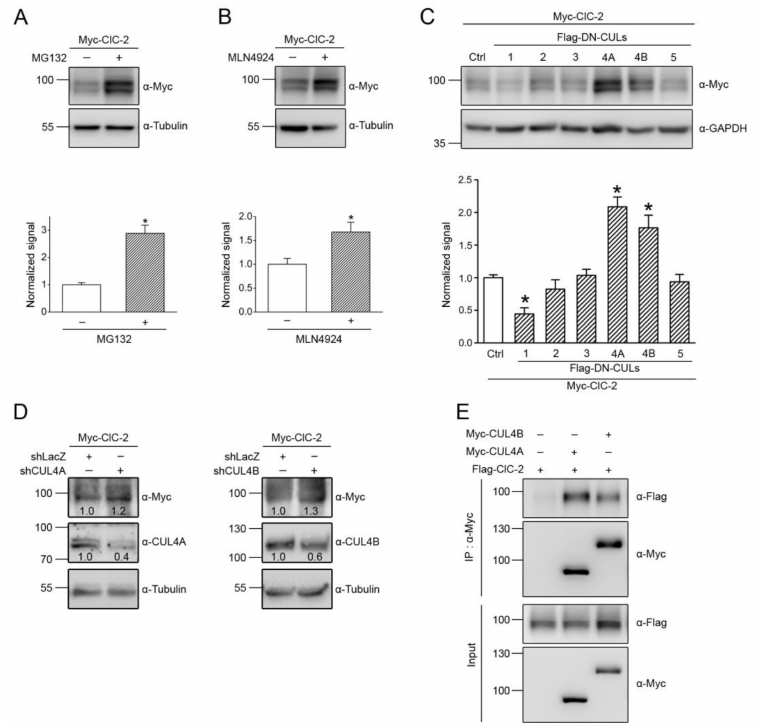
Figure 1. CUL4 mediates the protein degradation of ClC-2 channels. Myc- or Flag-tagged mouse ClC-2 channels (Myc-ClC-2, Flag-ClC-2) were overexpressed in HEK293T cells. ( A , B ) ( Upper panels ) Representative immunoblots showing the e ff ect of 24-h treatment of 10 µ M MG132 (in 0.1% DMSO) ( A ) or 10 µ M MLN4924 (in 0.1% DMSO) ( B ) on the protein expression of Myc-ClC-2. The molecular weight markers (in kilodaltons) and immunoblotting antibodies ( α -Myc and α -Tubulin) are labeled to the left and right, respectively. Tubulin was used as the loading control. ( Lower panels ) Quantification of relative ClC-2 protein levels. Protein density was standardized as the ratio of the ClC-2 signal to the cognate tubulin signal. Values from the MG-132-treated or the MLN4924-treated groups ( hatched bars ) were then normalized to those for the corresponding control ( clear bars ). Asterisks denote a significant di ff erence from the control (*, t test: p < 0.05; n = 6–12). ( C ) ( Upper panel ) Representative immunoblots illustrating the e ff ect of co-expressing Flag-tagged dominant-negative cullins (Flag-DN-CULs) on Myc-ClC-2. Co-expression with the Flag vector was used as the control experiment. GAPDH was used as the loading control. ( Lower panel ) Quantification of relative ClC-2 protein levels in the presence of various Flag-DN-CUL constructs (*, t test: p < 0.05; n = 7–16). ( D ) Representative immunoblots showing the e ff ect of shRNA knockdown of endogenous CUL4A / B (shCUL4A / B) in HEK293T cells on Myc-ClC-2. Infection with shLacZ was used as the control experiment. Tubulin was used as the loading control. The numbers on the immunoblot denote the relative ClC-2 protein levels. ( E ) Co-immunoprecipitation of Flag-ClC-2 and Myc-CUL4A / B. Cells were incubated in 10 µ M MG132 for 24 h before being solubilized. Co-expression with the Myc vector was used as the control experiment. Cell lysates were immunoprecipitated (IP) with α -Myc, followed by immunoblotting (IB) of the immunoprecipitates with α -Myc or the anti-Flag antibody ( α -Flag). Corresponding expression levels of ClC-2 and CUL4A / B in the lysates are shown in the Input lane. In all cases hereafter, input represents about 10% of the total protein used for